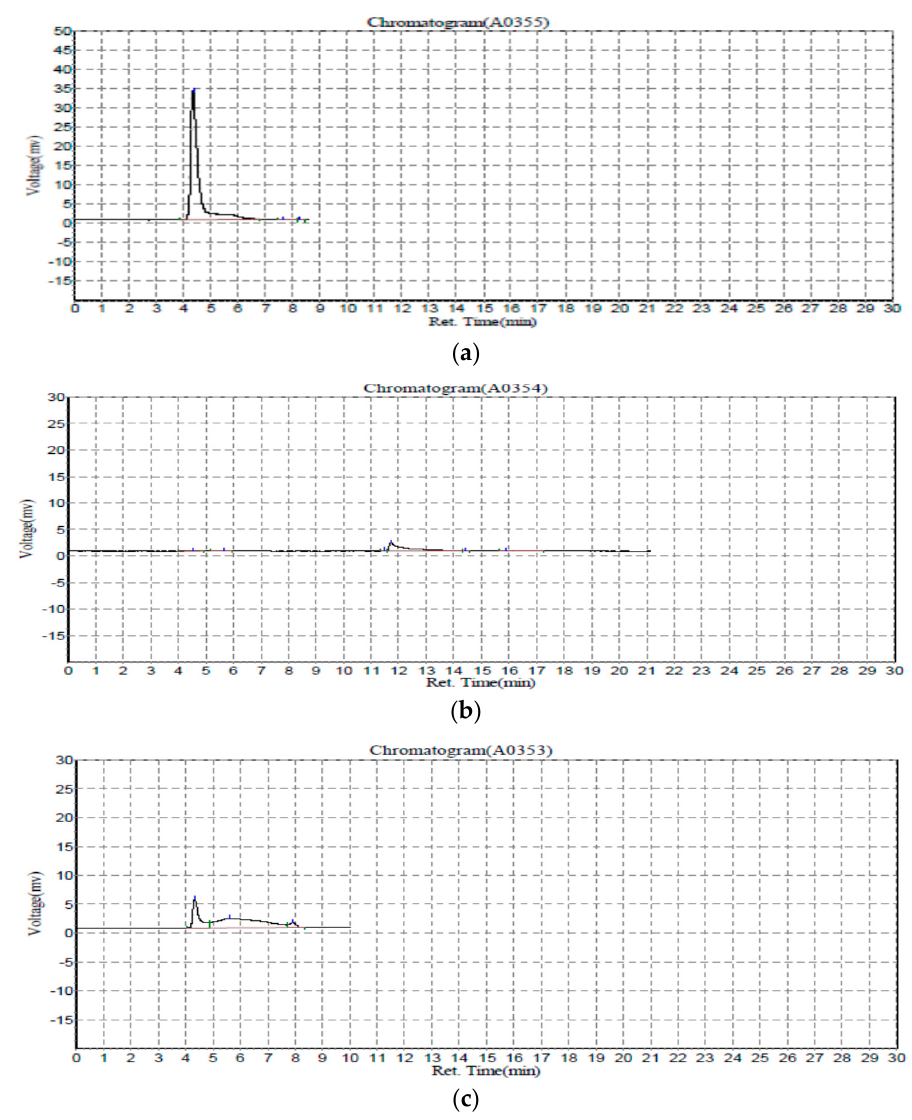
Figure 11. Extended GFC analysis: ( a ) lecithin liposome-encapsulated ZnO nanoparticles (1.0 mg/mL); ( b ) ZnO nanoparticles (1.0 mg/mL); and ( c ) lecithin liposomes, using λ ex = 350 nm and λ em = 395 nm for FD.